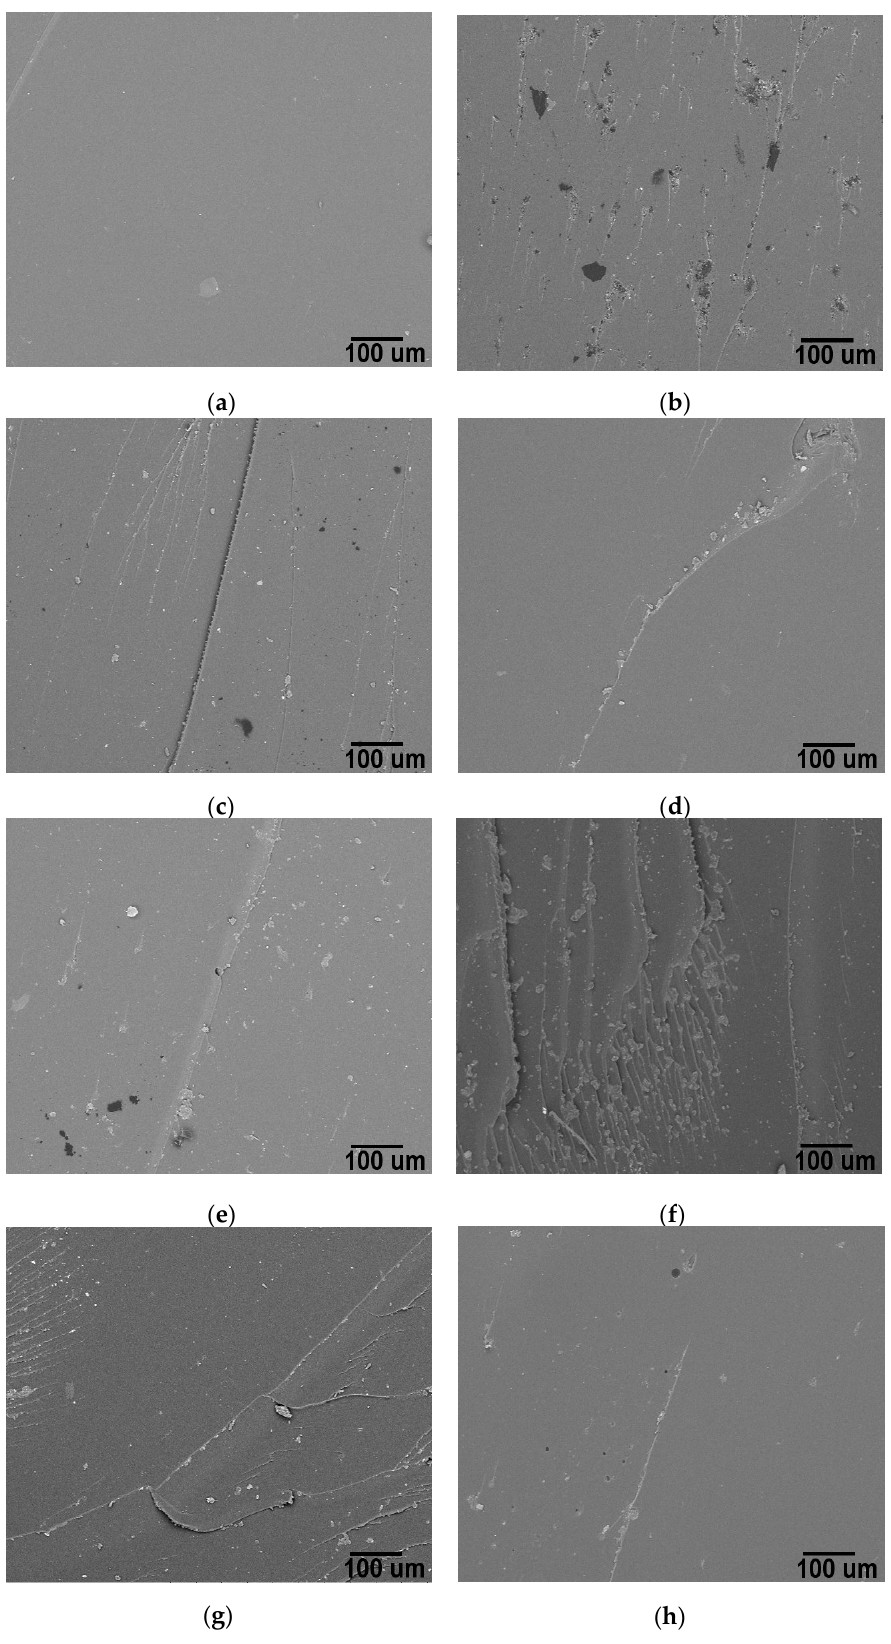
Figure 8. Micrograph of: ( a ) Neat epoxy ML ( b ) RGO 0.5 wt % ML; ( c ) MWCNT 0.1 wt % ML; ( d ) O-MWCNT 0.1 wt % ML; ( e ) RGO 0.1 wt % ML; ( f ) GO 0.1 wt % ML; ( g ) MWCNT-RGO 0.1–0.1 wt % ML; and ( h ) O-MWCNT-GO 0.1–0.1 wt % ML.